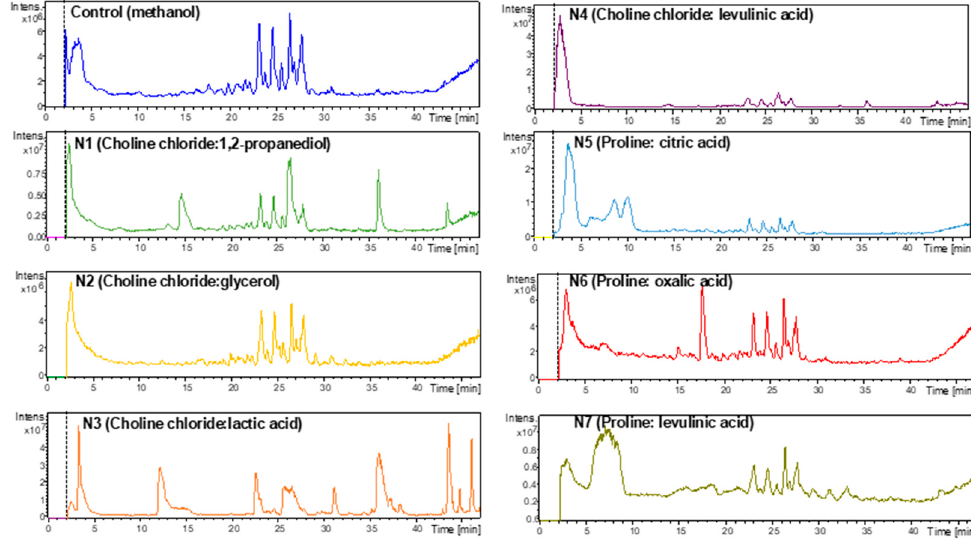
Figure 5. Representative HPLC-ESI-IT-MS chromatograms of the alkaloids from Peumus boldus leaves extracted with different NADES solvents. Control solvent (methanol) correspond to the chromatogram depicted in the first frame traced in blue color.